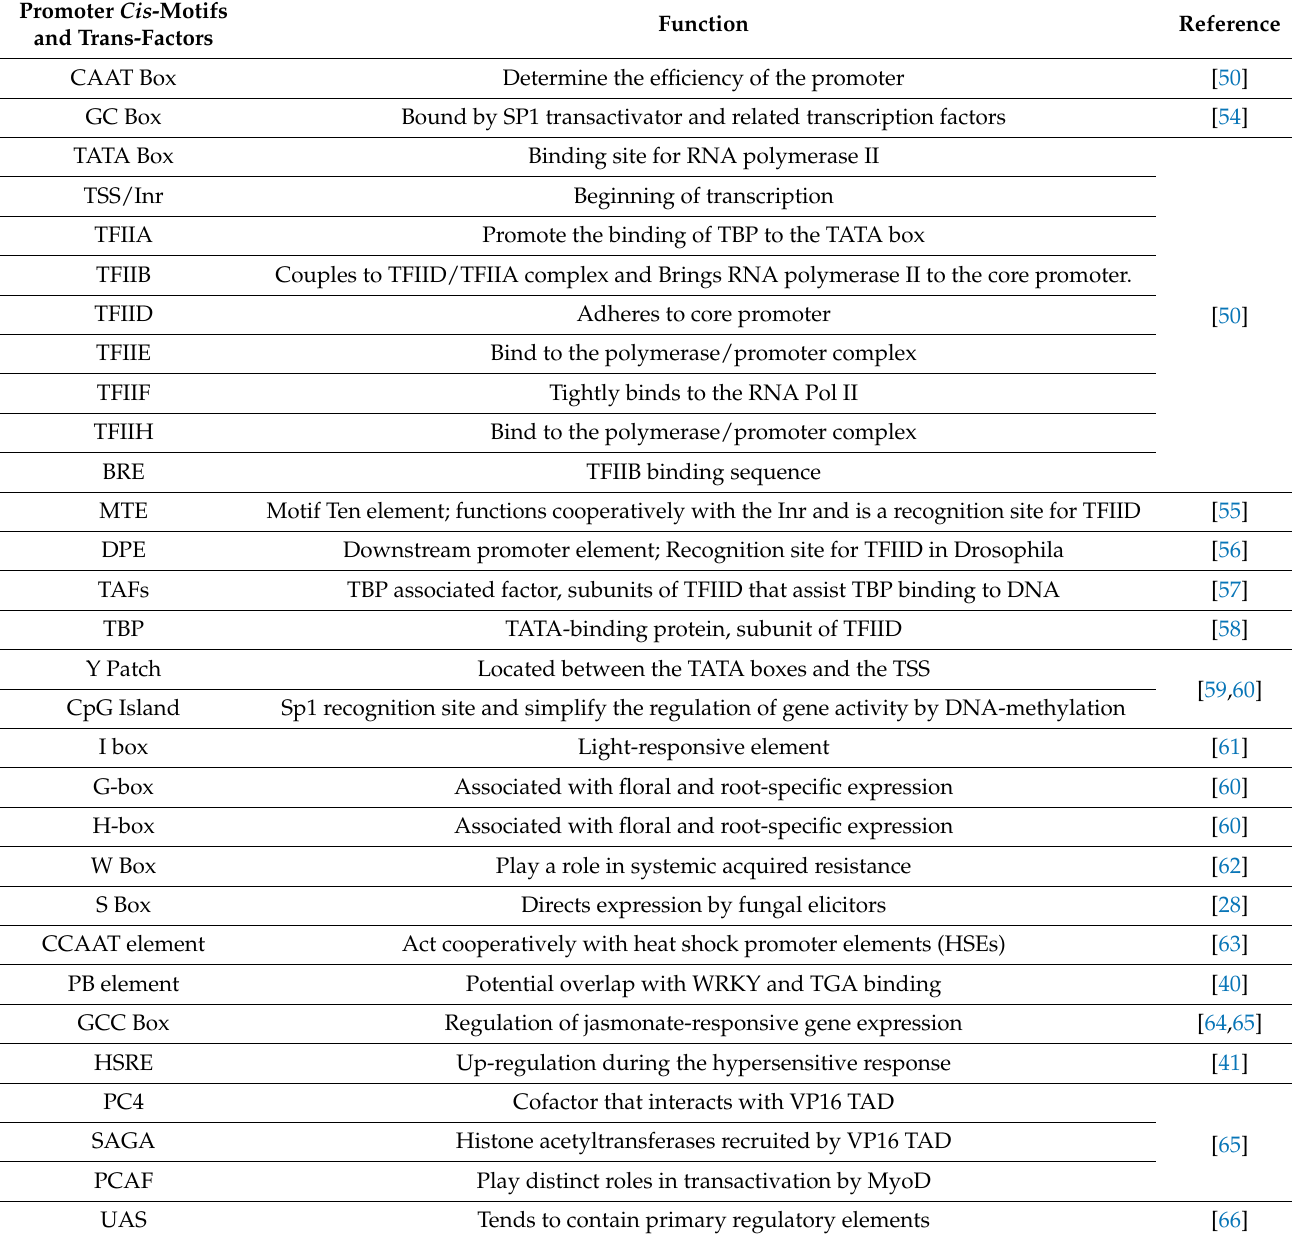
Table 1. List of various Cis -motifs and trans-factors in the promoter